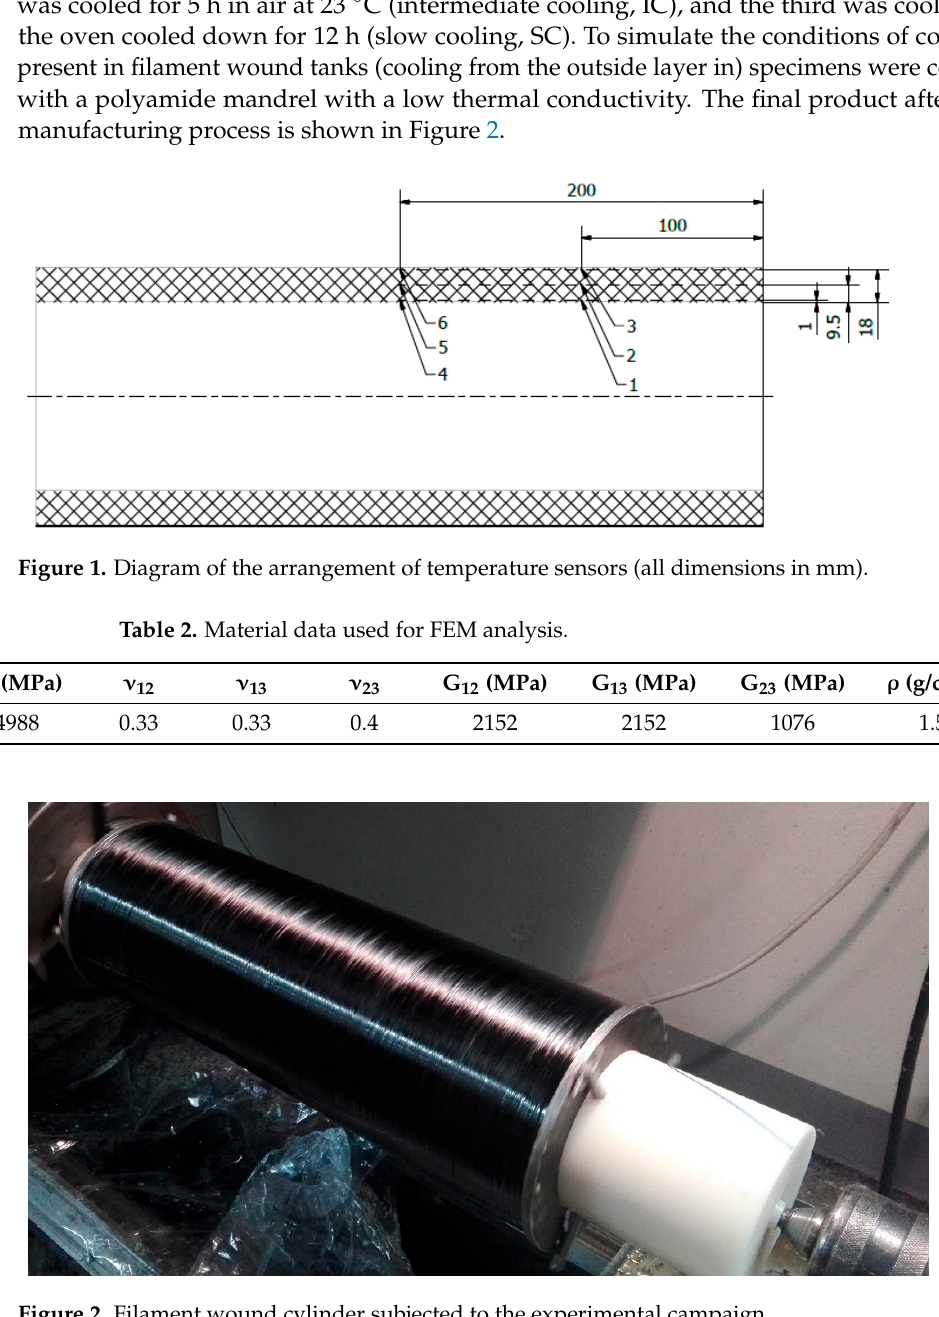
Figure 2. Filament wound cylinder subjected to the experimental campaign.